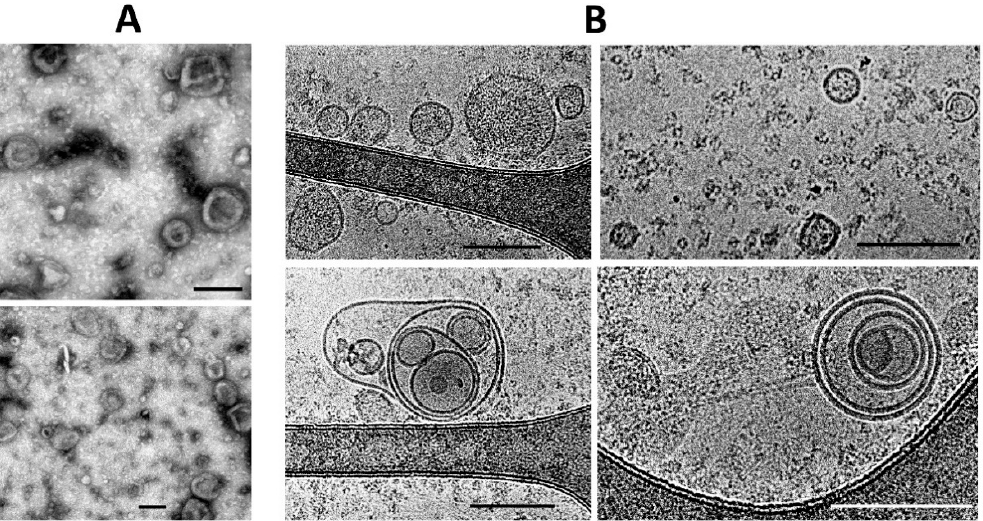
Figure 3. Examples of different configurations of exosomes obtained by conventional ( A ) and cryo ( B ) electron microscopy of vesicles supported on grid (grey long profiles) after centrifugation of the MSC culture medium at 108,000× g . Note the heterogeneity of sizes with average around 100 nm. Bar, 150 nm.